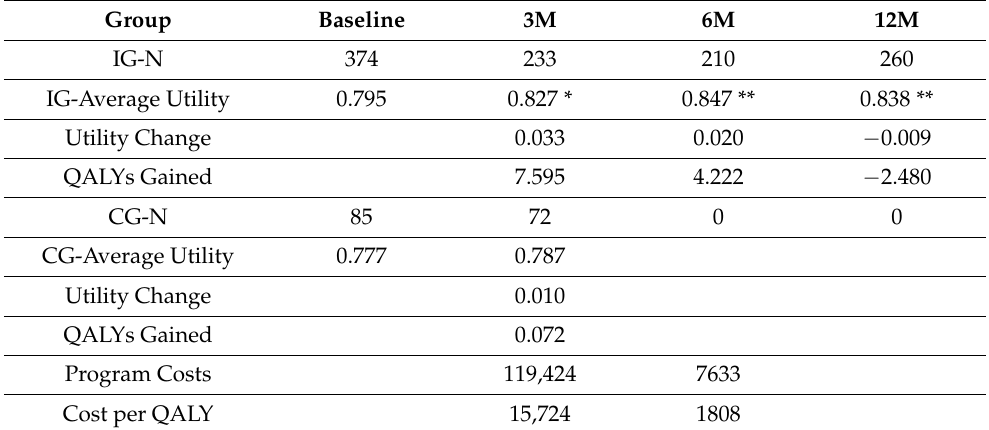
Table 3. Utility analysis of the Sheds for Life